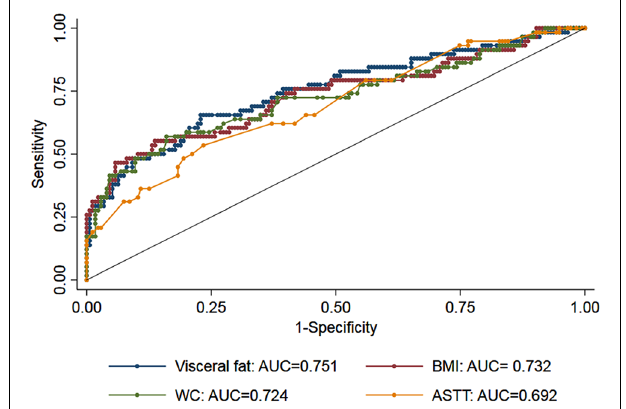
FIGURE 3 | Receiver operating characteristic (ROC) curves for measurements of visceral fat (blue marker), body mass index (BMI: red marker), waist circumference (WC: green marker), and abdominal subcutaneous tissue thickness (ASTT: yellow). The area under the ROC curves (AUC) for the three measurements showed similar discrimination ( p =